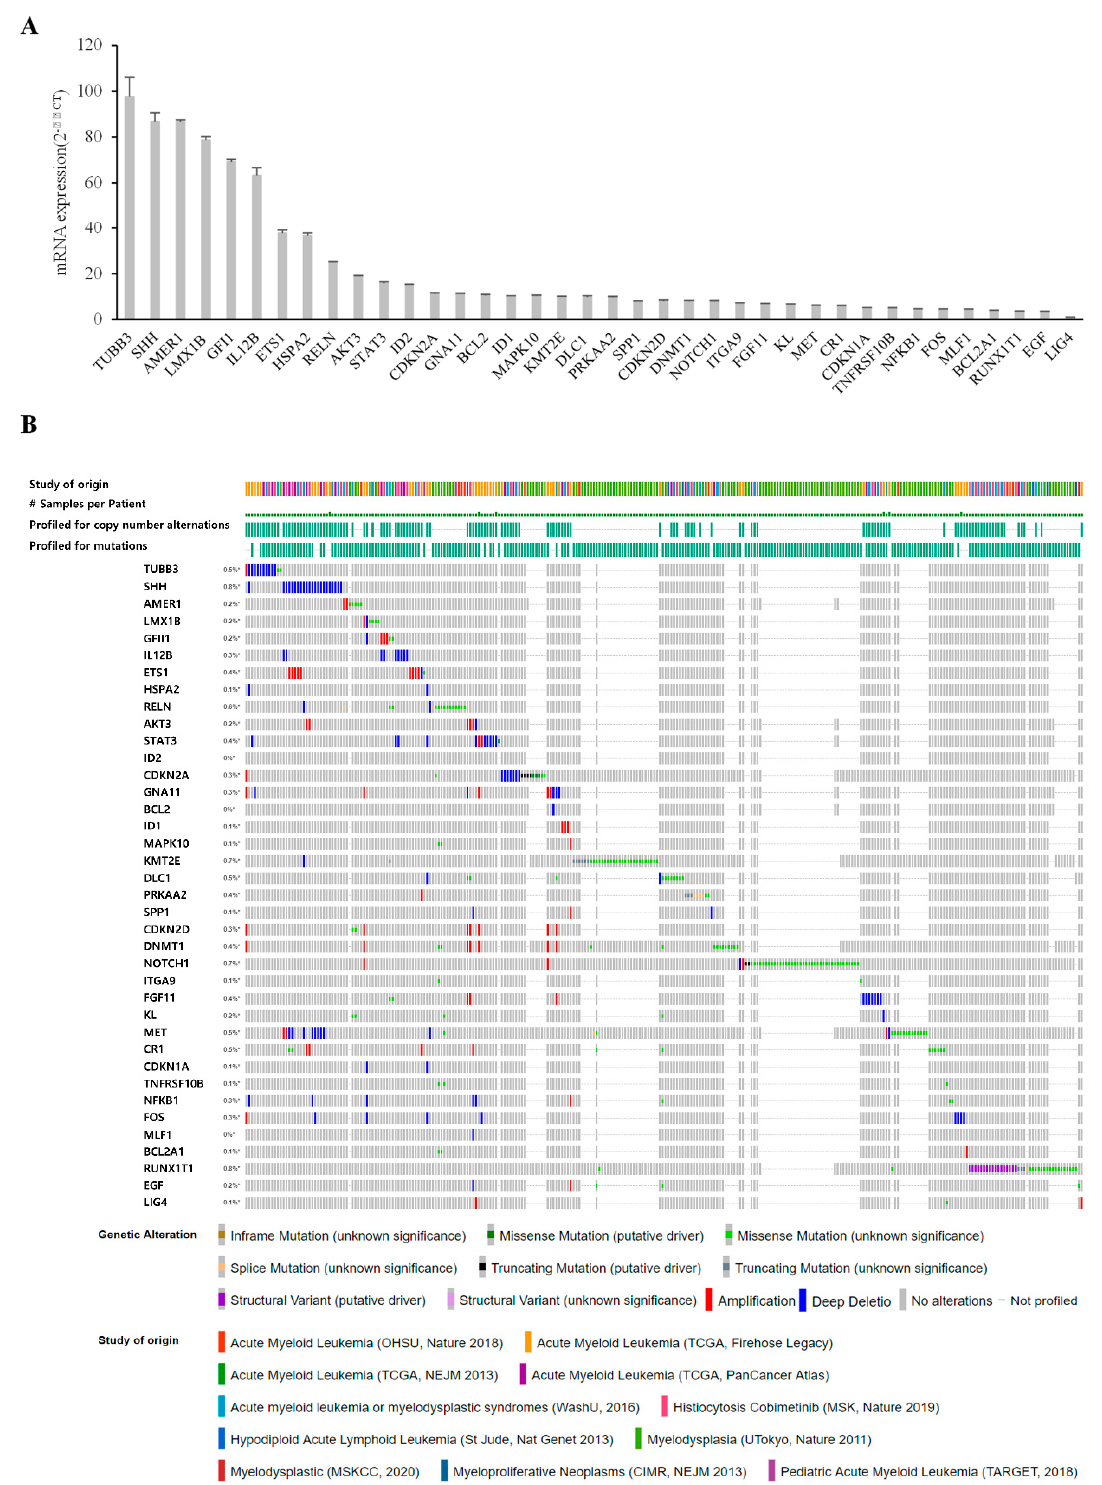
Figure 5. Verification of candidate genes by qRT-PCR and cBioPortal analysis. ( A ) The graph depicts mRNA levels of candidate genes that were differentially expressed between F-36P cells and F-36P/DEC cells. All candidate genes were significantly upregulated in F-36P/DEC cells. Differential expression is considered significant at p < 0.05. Error bars indicate standard deviations ( n = 3). ( B ) Myeloid neoplasm datasets (http://cbioportal.org/, accessed on 1 October 2021) were interrogated for genetic alterations in candidate genes. Alterations were found in 0% to 0.8% of the respective analyses and are depicted graphically. Many candidate genes exhibited amplification